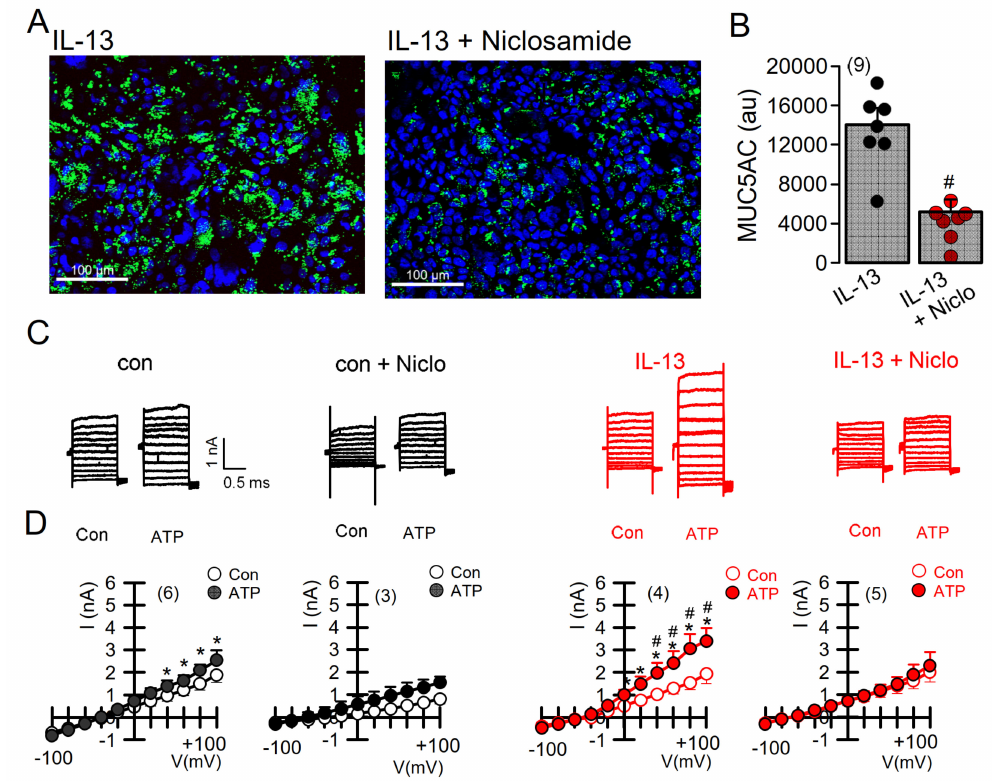
Figure 5. Expression of MUC5AC and activation of TMEM16A in Calu-3 airway epithelial cells is inhibited by niclosamide. ( A ) Expression of MUC5AC induced by IL-13 (20 ng/mL; 72 h) in Calu-3 airway epithelial cells was inhibited by simultaneous incubation with niclosamide (1 µ M). Bar = 100 µ m. ( B ) Quantification of MUC5AC expression indicating inhibition by niclosamide (Niclo). ( C ) Current overlays from whole-cell patch clamp experiments before and after induction of MUC5AC expression by IL-13. Activation of whole-cell currents by purinergic stimulation (ATP, 100 µ M) was enhanced by IL-13, which was completely inhibited by acute application of niclosamide (1 µ M). ( D ) Corresponding current/voltage relationships. The inhibitor of Ca 2+ -activated KCNN4 K + channels, TRAM-34 (100 nM), was present in all patch clamp experiments to avoid potential activation of Ca 2+ -activated K + channels. Mean ± SEM (number of cells). * significant activation by ATP ( p < 0.05, paired t -test). # significant difference when compared to the absence of IL-13 ( p < 0.05, unpaired t